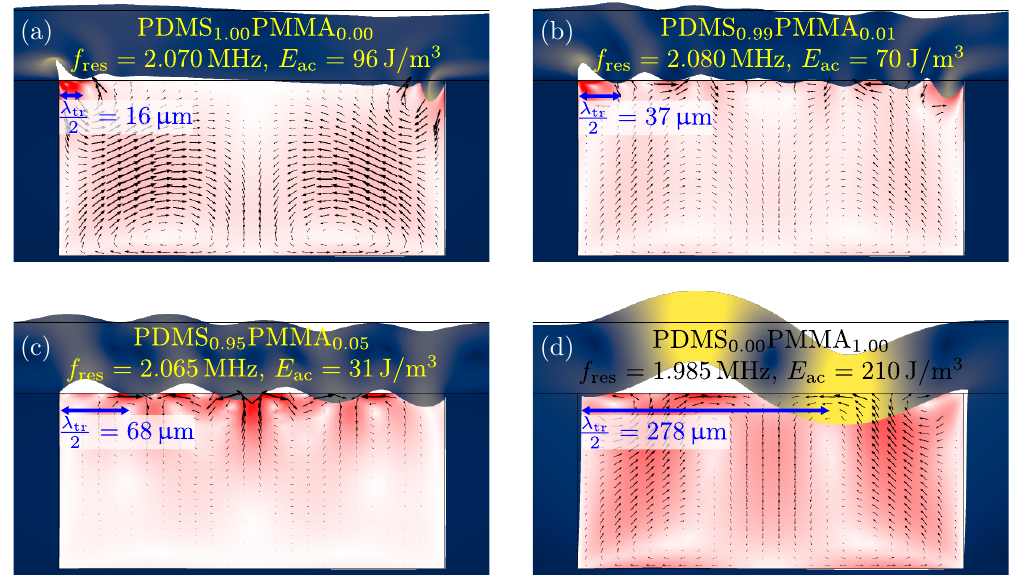
Figure 6. Zoom-in on the resonance modes for four different mixing ratios x of the artificial polymer alloy PDMS x PMMA 1 − x with ( a ) x = 1.00, ( b ) x = 0.99, ( c ) x = 0.95, and ( d ) x = 0.0. For each case, the resonance frequency f res is noted together with the average acoustic energy density E ac , and the transverse wavelength λ tr in the artificial PDMS-PMMA polymer cover. The color plots indicates (cid:12) (cid:12) the particle velocity magnitude (cid:12) v pa (cid:12) in the water ranging from 0 (white) to the maximum value v max pa = 258 µm/s (red), and of the displacement u in surrounding solids ranging from 0 (dark blue) to 70 nm (yellow). The deformation is scaled 500 times to be